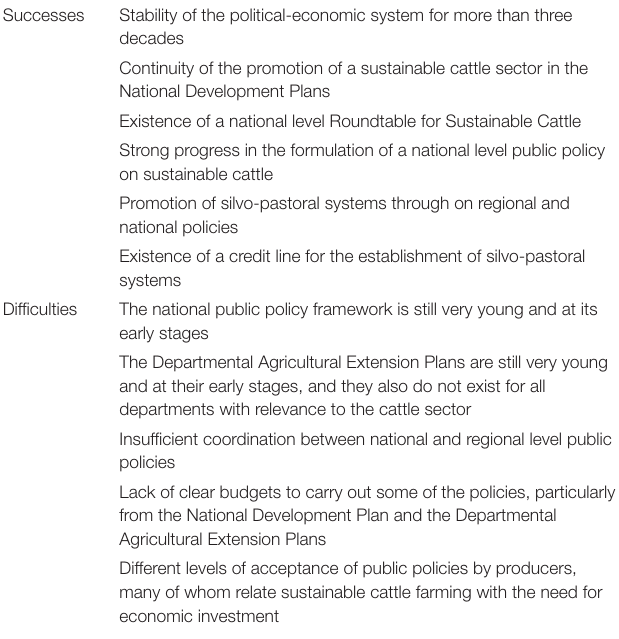
TABLE 2 | Successes and difficulties in the implementation of public policies in